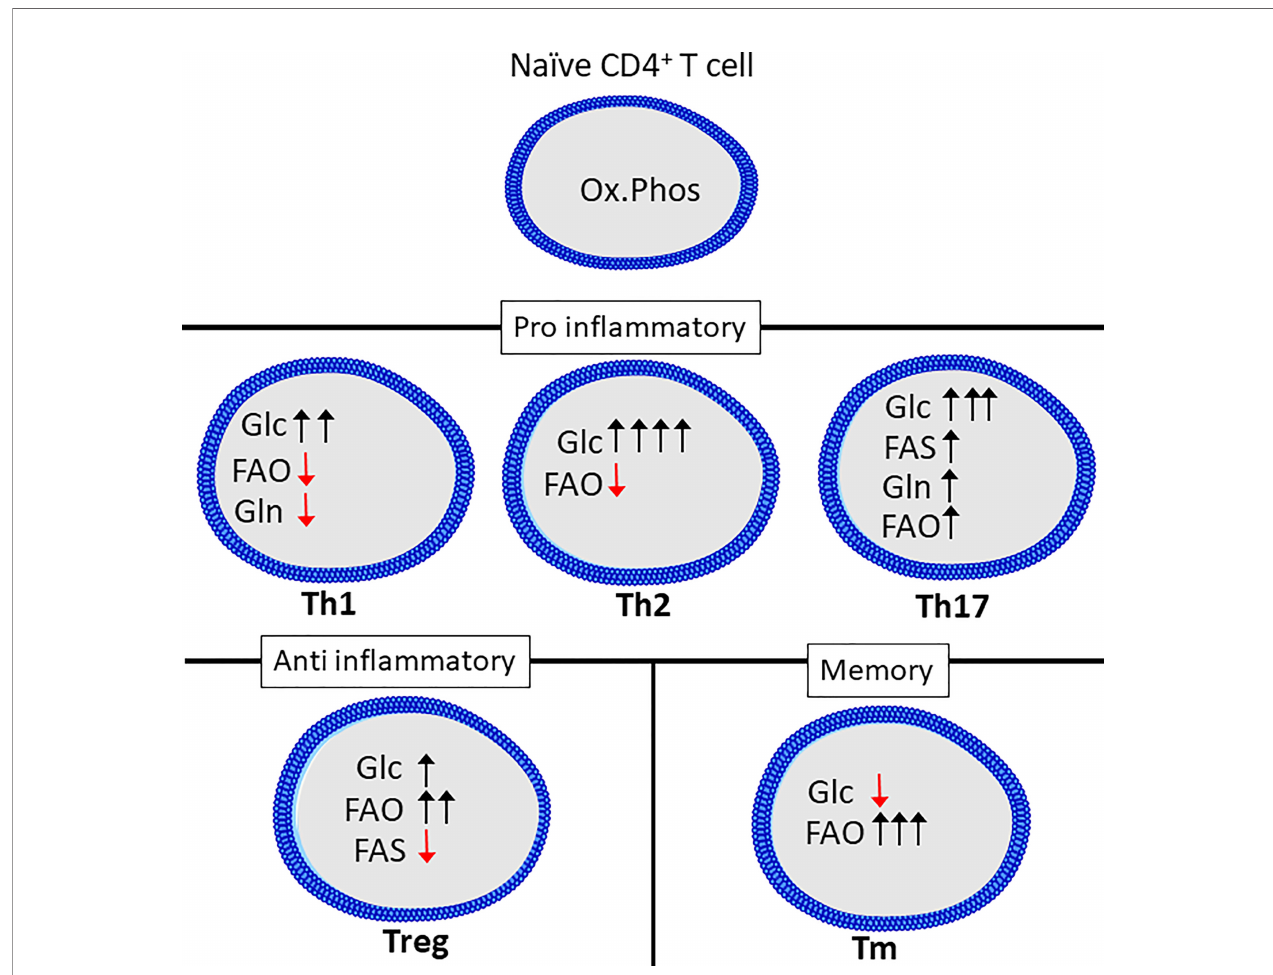
FIGURE 2 | Th subsets display distinct metabolic programs. Quiescent Th cells rely mainly on oxidative phosphorylation (Ox.Phos) to maintain homeostasis, while the effector subsets are characterized by increased glycolytic metabolism (Glc) as well as a differential reliance on glutaminolysis (Gln), fatty acid oxidation (FAO and fatty acid synthesis (FAS) to support effector functions. Figure was created using assets from Servier Medical Art, licensed under a Creative Common Attribution 3.0 Generic License.